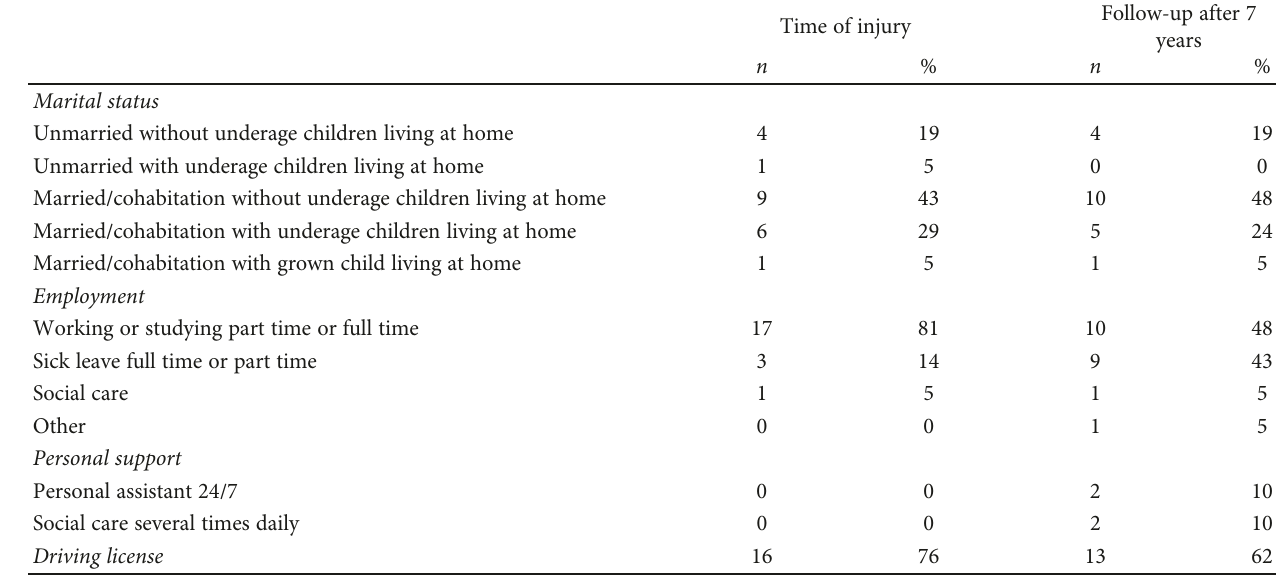
Table 2: Marital status, employment and livelihood, personal support, driving license at time of injury (2010-2011) and at follow-up after 7 years ( n = 21 ).